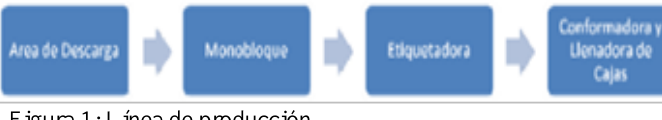
Figura 1: Línea de